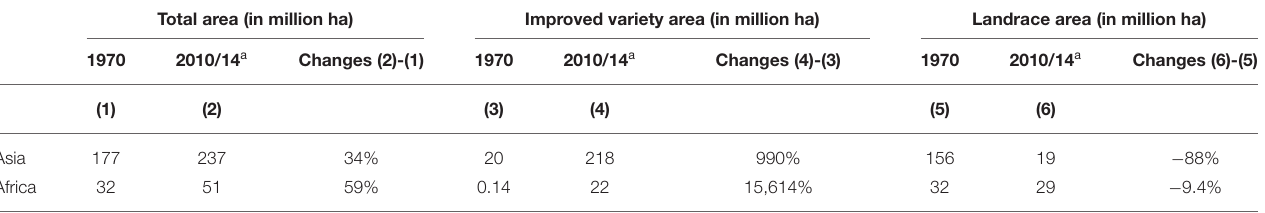
TABLE 1 | Total area, area planted to improved varieties and landraces in Asia and Africa from 1970 to 2010/14.